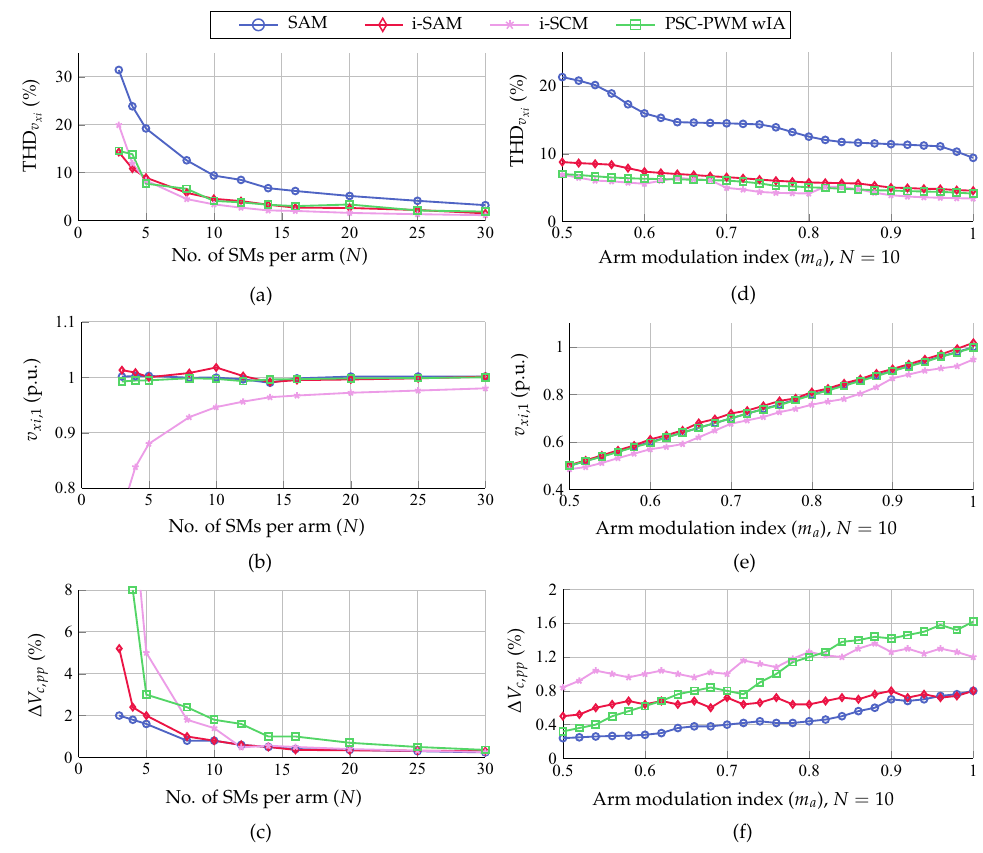
Figure 12. Comparative graphics of the proposed modulation technique versus known modulation techniques. Number of submodules per arm “ N ”, (a) front THD of the inverter output voltage, (b) front fundamental of output voltage, (c) front peak-to-peak variation of the submodule capacitor voltage. Arm modulation index “ m a ” with N = 10, (d) front THD of the inverter output voltage, (e) front fundamental of output voltage, (f) front peak-to-peak variation of the submodule capacitor voltage.